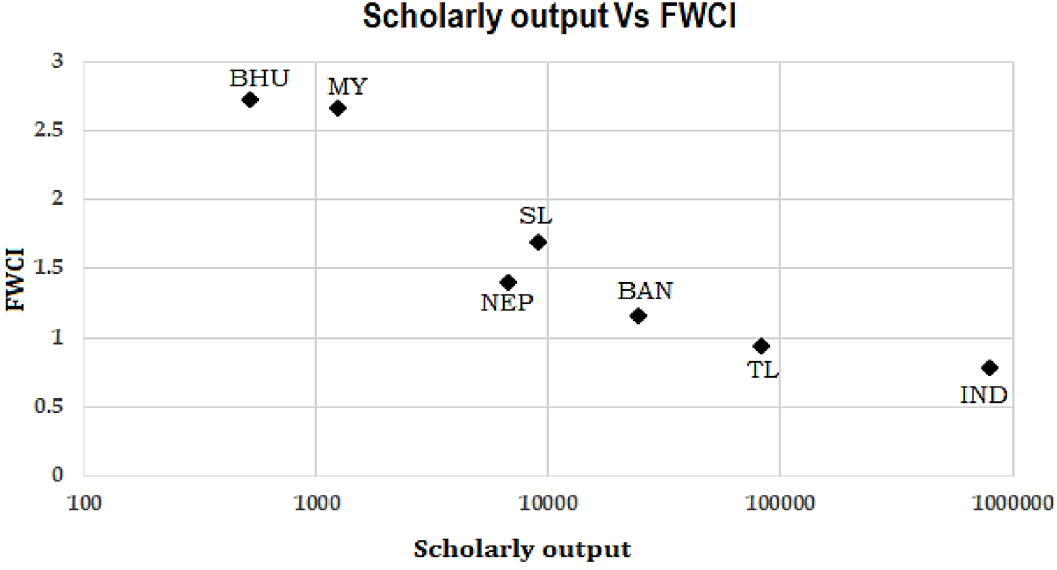
Figure 5. Comparison of FWCI with the scholarly output of BIMSTEC countries. India (IND), Thailand (TL), Bangladesh (BAN), Sri Lanka (SL), Nepal (NEP), Myanmar (MY), Bhutan